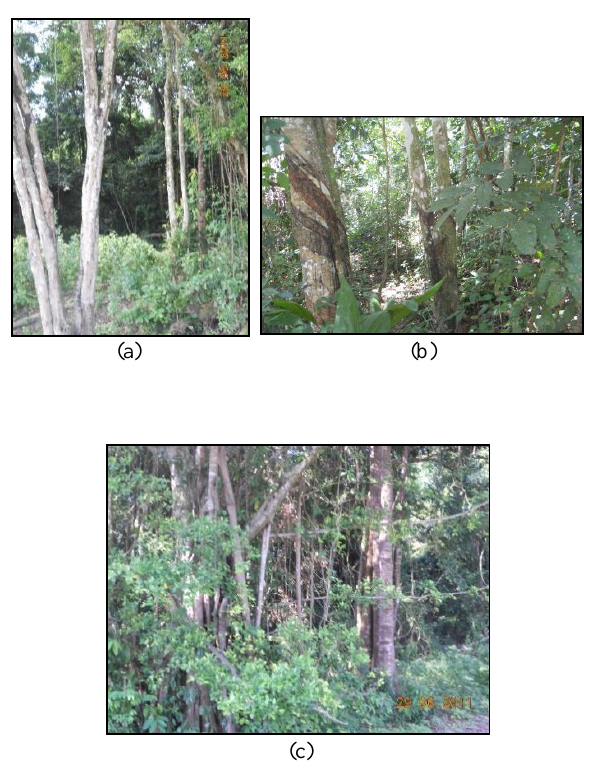
Figure 3. Photographs taken over study area covered with rubber trees (a) and (b) with understorey vegetation (c) mixed forest Airborne LiDAR data (Figure 4 and Figure 5) were collected by survey firm company on January 2009 using REIGL laser scanner which is mounted on a British Nomad aircraft. The data were delivered in LAS format and the average point density is about 1.3 points per meter square (rubber trees) and 3.2 points per meter square (mixed forest). The airborne LiDAR data were processed using an automated methods in classifying ground returns and using manual interpretation. This process known